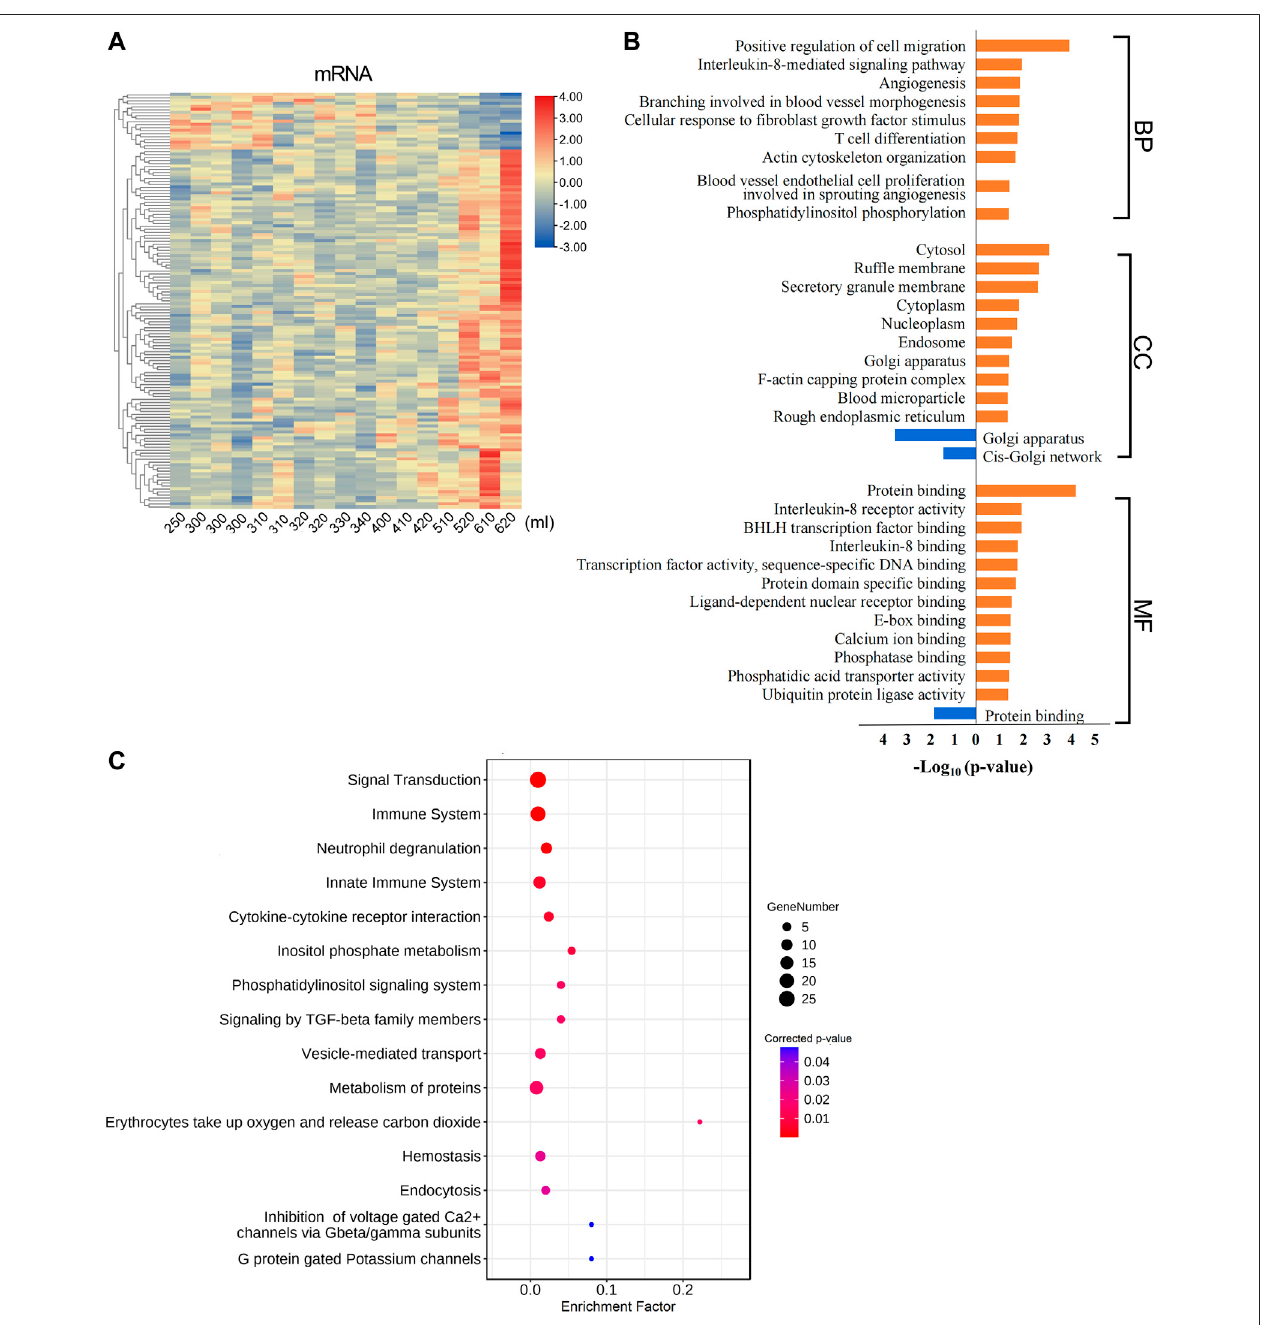
FIGURE5| PostpartumbleedingcorrelatedmRNAsfunctionannotation. (A) Heatmapofexpressionofpostpartumbleeding – correlatedmRNAs.Dataassociated with this fi gure can be found in Supplementary Table S9 . (B) Bar diagram of partial GO term clusters of positively (orange) and negatively (blue) correlated postpartum bleeding mRNAs. (C) Bubble diagram of signi fi cantly enriched pathways for postpartum bleeding – correlated mRNAs.